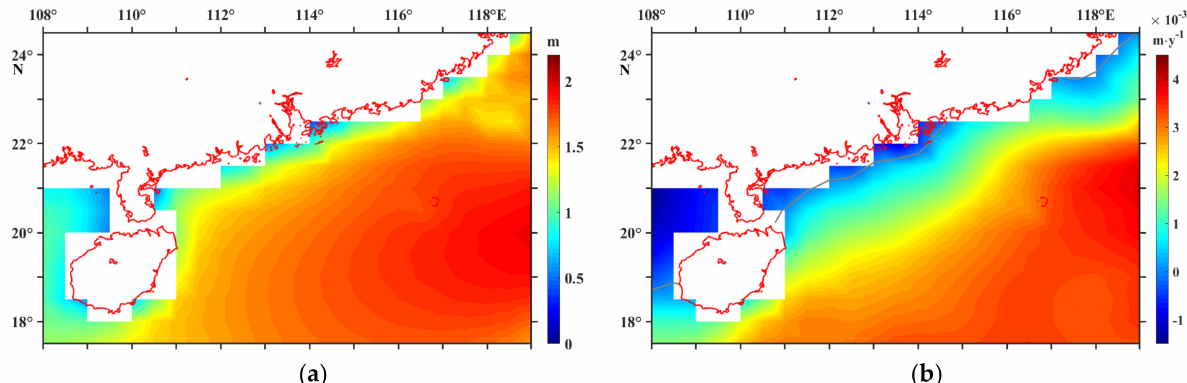
Figure 11. ( a ) Spatial distribution of the annual mean significant wave height in the northern South China Sea averaged from 1979 to 2019. ( b ) Trend of the annual mean significant wave height. Grey contours represent